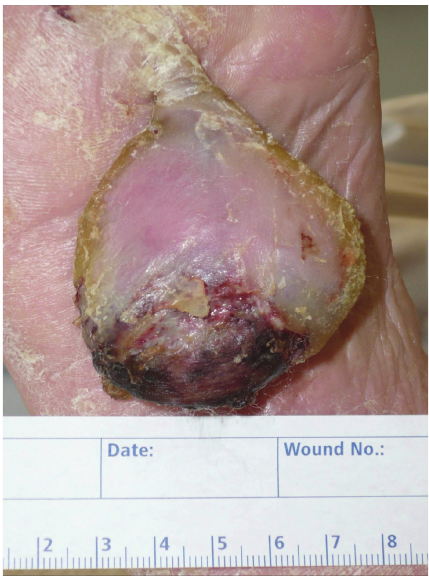
Figure 1: Ulcerated fibrolipoma of the plantar surface.